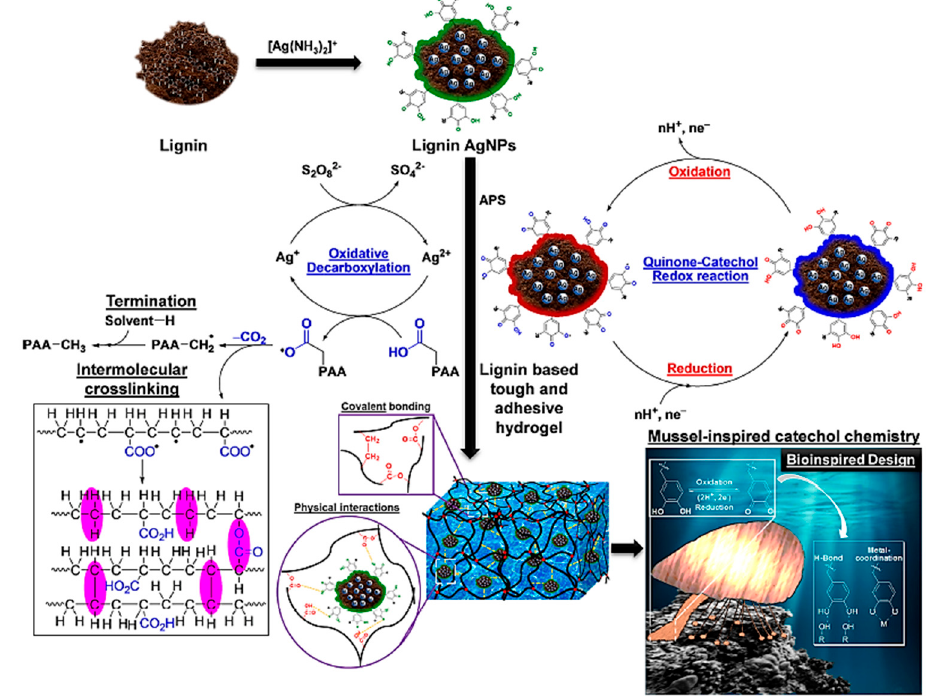
Figure 3. Schematic of the chemical reaction of marine mussel catechol and the combined reactions of oxidative decarboxylation and redox catalysis of quinone-catechol used to form the lignin-based adhesive antimicrobial hydrogel. AgNPs = silver nanoparticles; APS = ammonium persulfate; PAA = poly (acrylic acid) (Reprinted with permission from ref. [66]). Copyright 2020, American Chemical